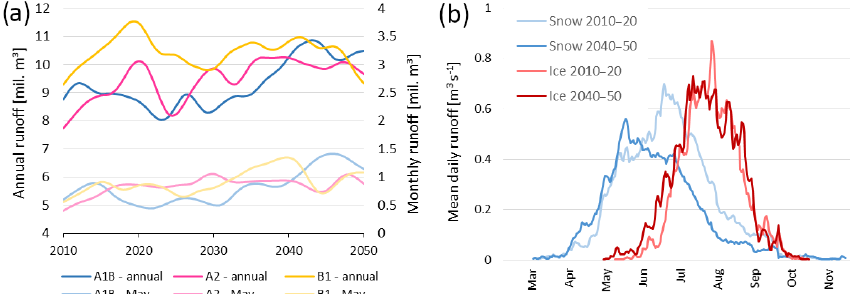
Figure 8. (a) Accumulated annual runoff and monthly runoff for May between 2010 and 2050. Data smoothed with a 10-year low-pass filter. (b) Mean daily runoff (averaged over all scenarios) from snowmelt and ice melt for the periods of 2010–2020 and